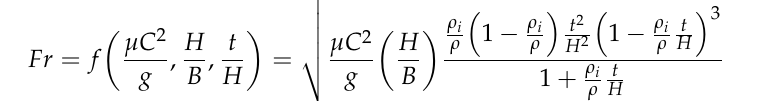
Table 1. Calculated Chézy coefficients for 11 experimental runs.